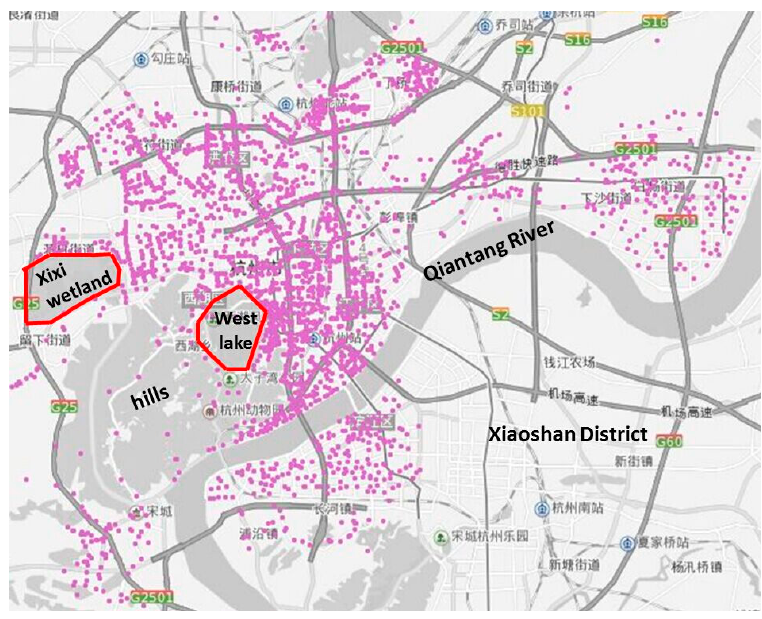
Figure 1. The distribution of stations in Hangzhou.